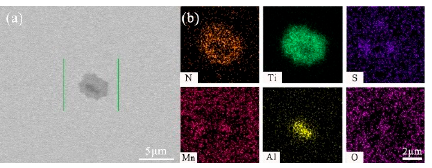
Figure 11. Typical MnS diagrams with oxides and TiN as cores ( a ) SEM morphology of inclusions; ( b ) composition distribution of inclusions.